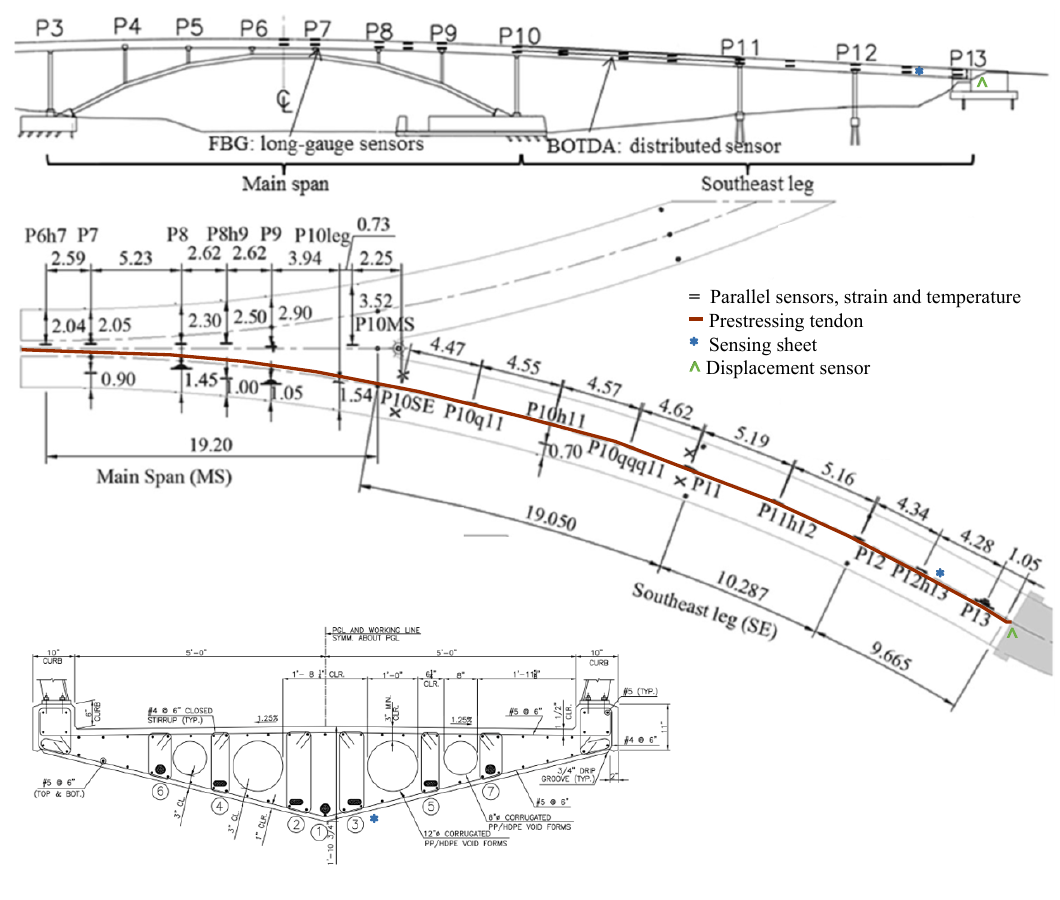
Figure 3. Locations of the strain and temperature sensors for Streicker Bridge. The cross-sectional view is at the location of the displacement sensor on the South-East leg